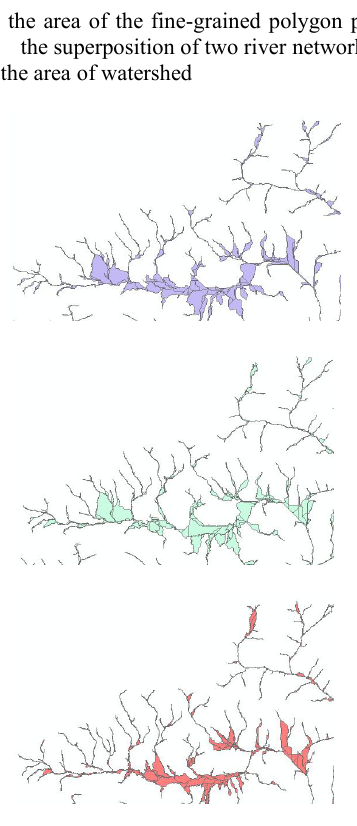
Figure 7. Parts of river network discrepancy curves （ Catchment area threshold is 1km 2 ; upper ： ASTER- SRTM; middle ： ASTER-ZY3 DSM; lower ： SRTM-ZY3 DSM ） From figure 7, the river networks extracted from ZY3 DSM has the highest similarity with those from SRTM at a visual analysis of the river network discrepancy curves above, and as figure 8 shown, ZY3 DSM and SRTM have the smallest river network discrepancy under the same catchment area threshold.